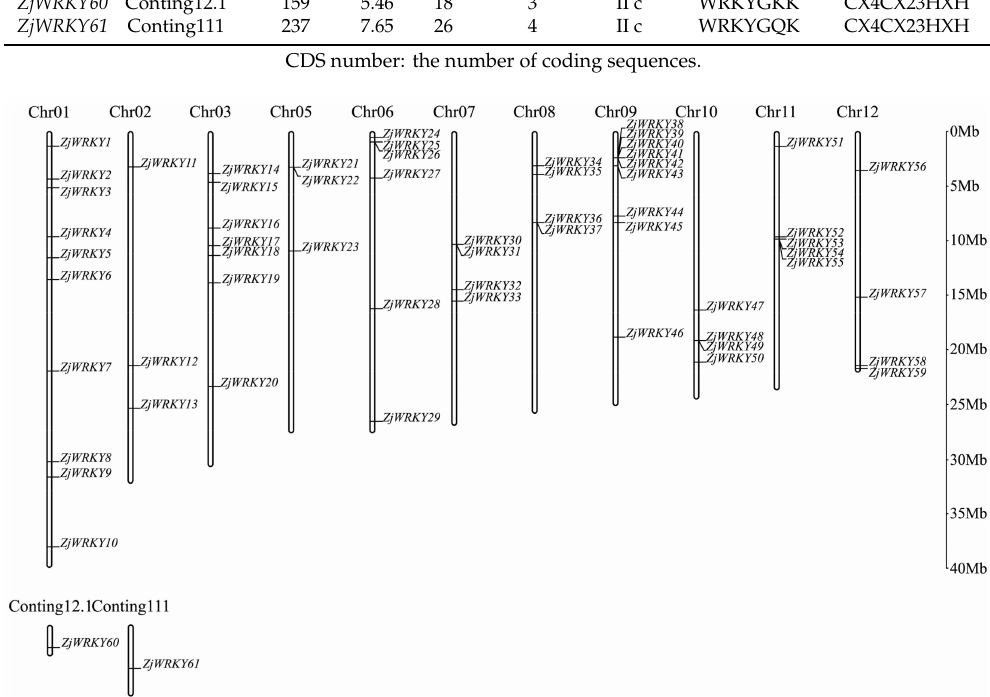
Figure 1. Distribution of ZjWRKY genes on pseudo chromosomes of ‘Junzao’. The scale on the right is in million bases